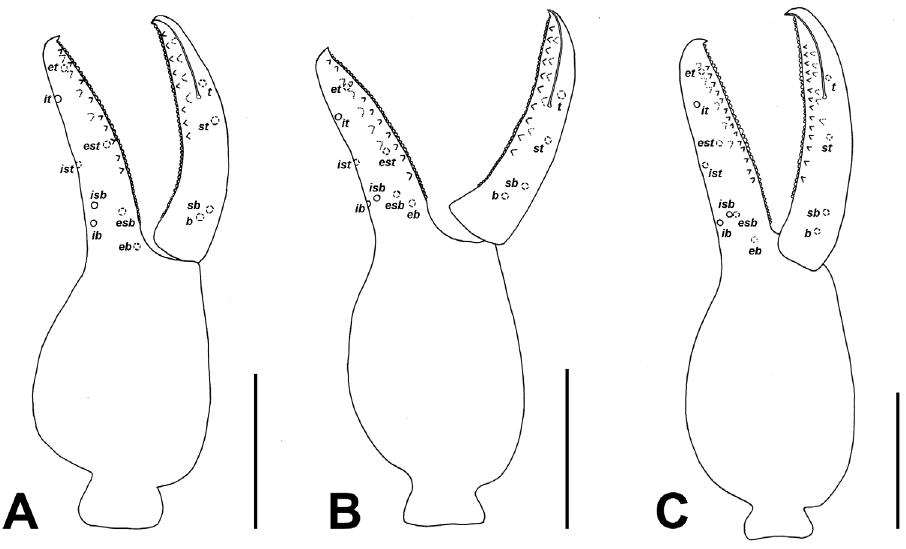
Figure 4. Palpal chela of Lasiochernes species, showing the trichobothrial pattern. A L . cretonatus male B L . jonicus female C L . pilosus male. Abbreviations in terminology of trichobothria: movable finger: t – terminal, st –subterminal, sb –subbasal, b –basal; fixed finger: et –exterior terminal, est –exterior subterminal, esb –exterior subbasal, eb –exterior basal, it –interior terminal, ist –interior subterminal, isb –interior subba- sal, ib –interior basal. Scale lines: 0.5